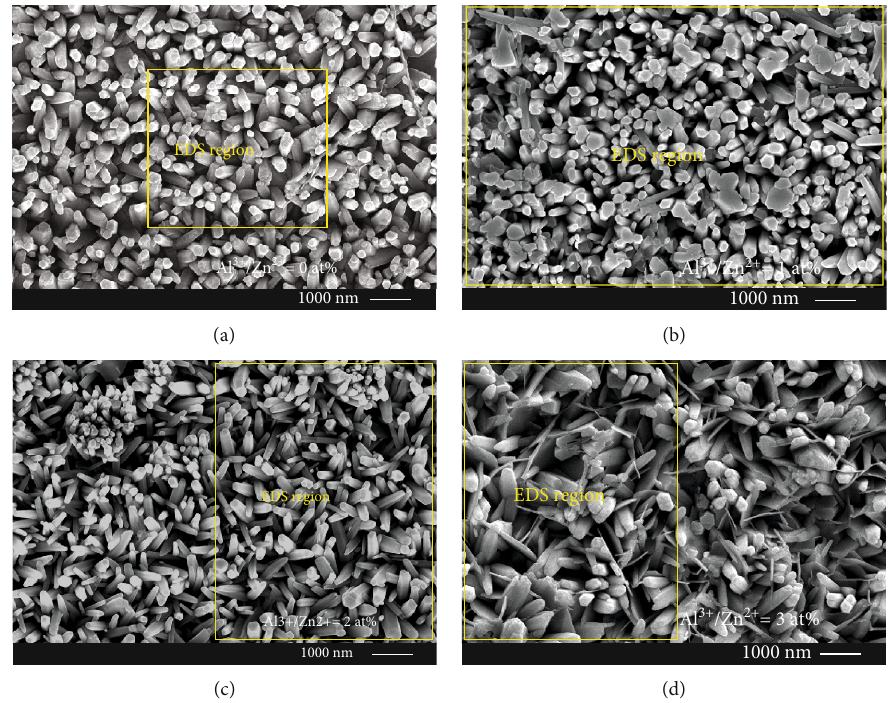
Figure 3: SEM images of ZnO fi lms formed on FTO substrates by electrodeposition method at a constant potential -1.5 V from 3 mM ) aqueous solutions containing Al(NO Zn(NO 3 2 at 80 ° C for 60min with a fi xed electrode distance